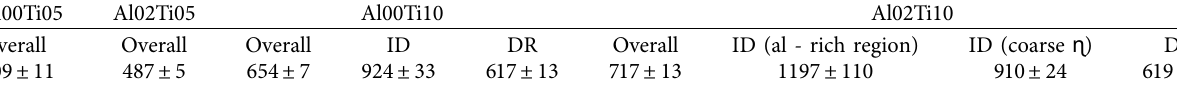
Table 2: Overall hardness and microhardness (HV) of each phase in the four HEAs [33].